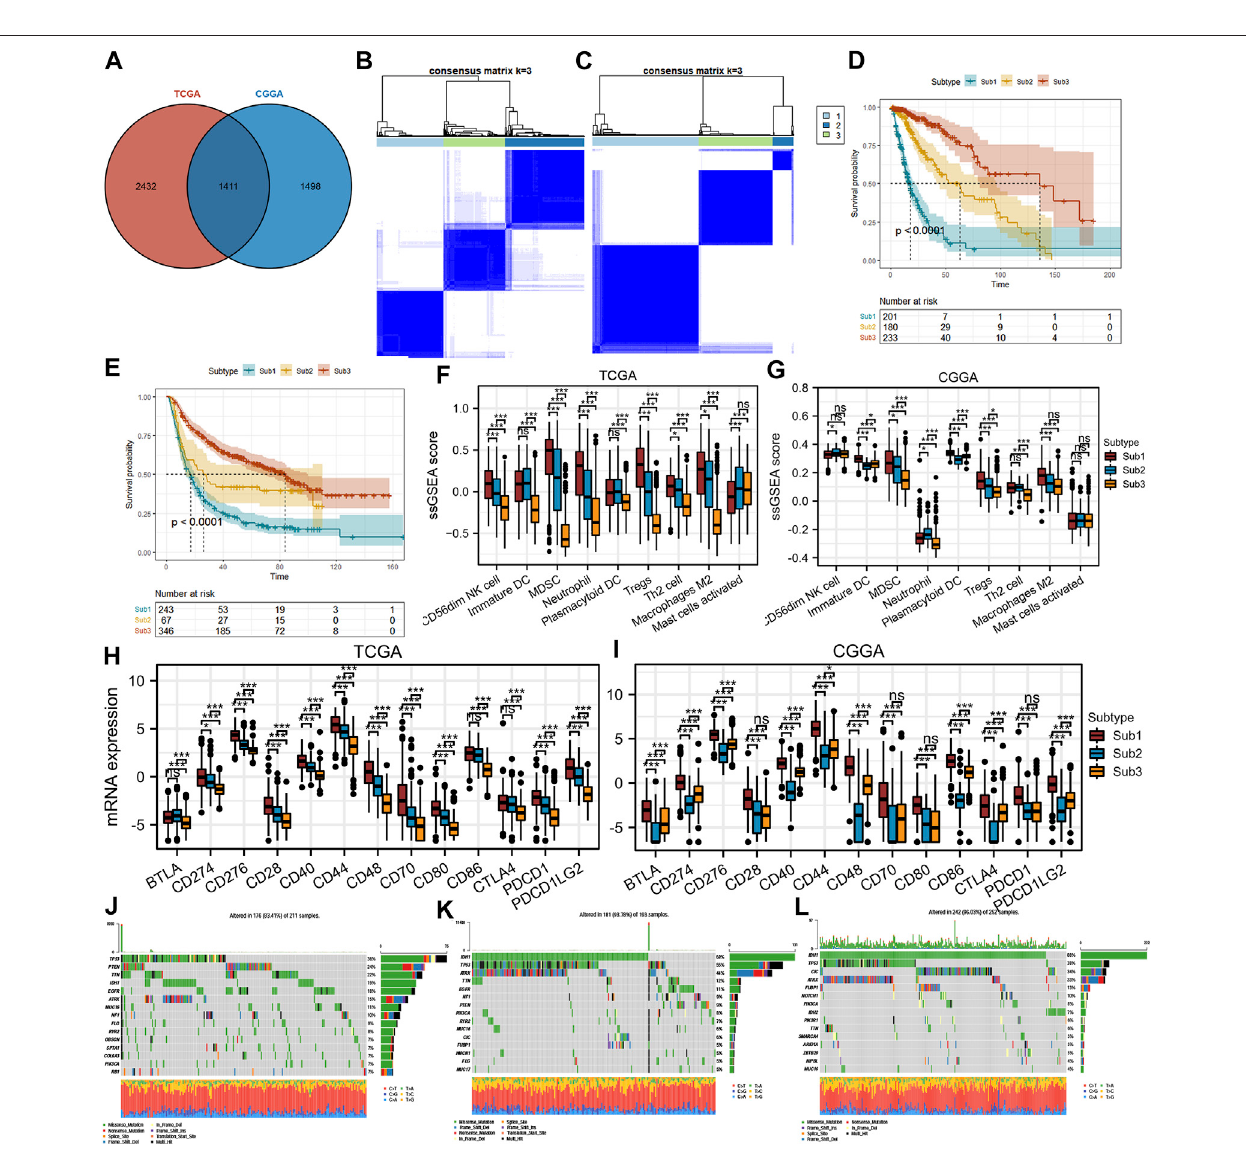
FIGURE 9 | Differences in protumor immune cells, immune checkpoint markers, mutations, and the prognosis of SYK-associated subtypes in the TCGA and CGGAcohorts. (A) Identi fi cationofSYK-associatedgenesintheTCGAandCGGAcohorts. (B – C) Identi fi cationandvalidationofSYK-associatedsubtypesintheTCGA (B) and CGGA cohorts (C) . p values were calculated by the log-rank test, and p < 0.05 was considered signi fi cant. (D – E) The difference in prognosis between diffuse glioma with SYK-associated subtypes in the TCGA (D) and CGGA cohorts (E) . (F – G) The difference in protumor immune cells between diffuse glioma with SYK- associatedsubtypesintheTCGA (F) andCGGAcohorts (G) . (H – I) ThedifferenceinimmunecheckpointmarkersbetweendiffusegliomawithSYK-associatedsubtypes in the TCGA (H) and CGGA cohorts (I) . (J – L) Mutational pro fi les of SYK-associated subtypes (- no signi fi cance, * p < 0.05, and *** p <